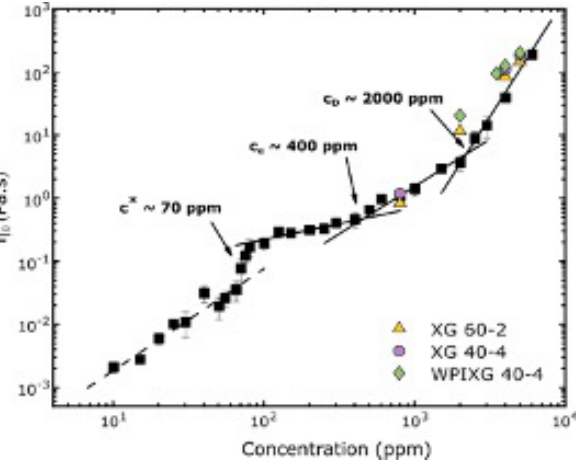
Figure 6: Superposition of zero-shear viscosity values over the η 0 vs concentration graph developed by Wyatt & Liberatore [14] for several concentrations of salt-free xanthan gum solutions in